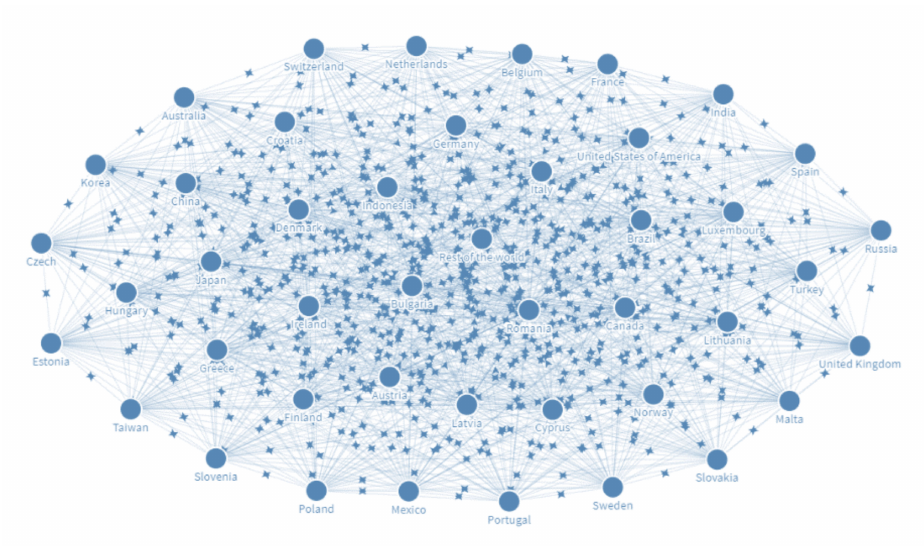
Figure 1. Sectoral GVC network. Each country (node) imports/exports the same share (identical weights) from/to all other